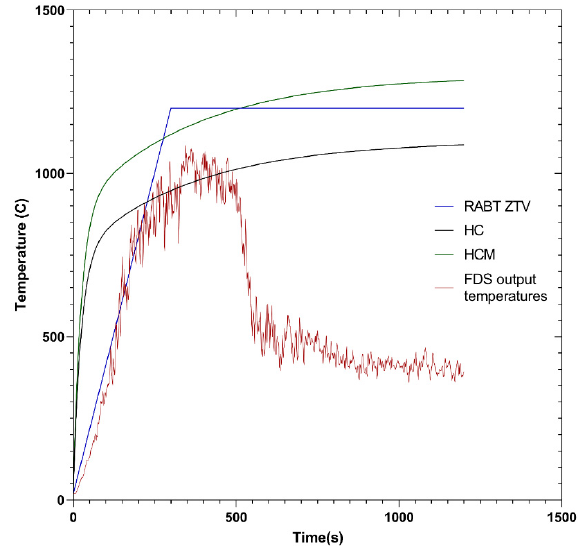
Figure 5. Tunnel ceiling temperature (z = 7 m) above the fire source (x = 795 m), and comparison of the FDS output for Scenario C and the HC, HCM, and RABT ZTV standard fire